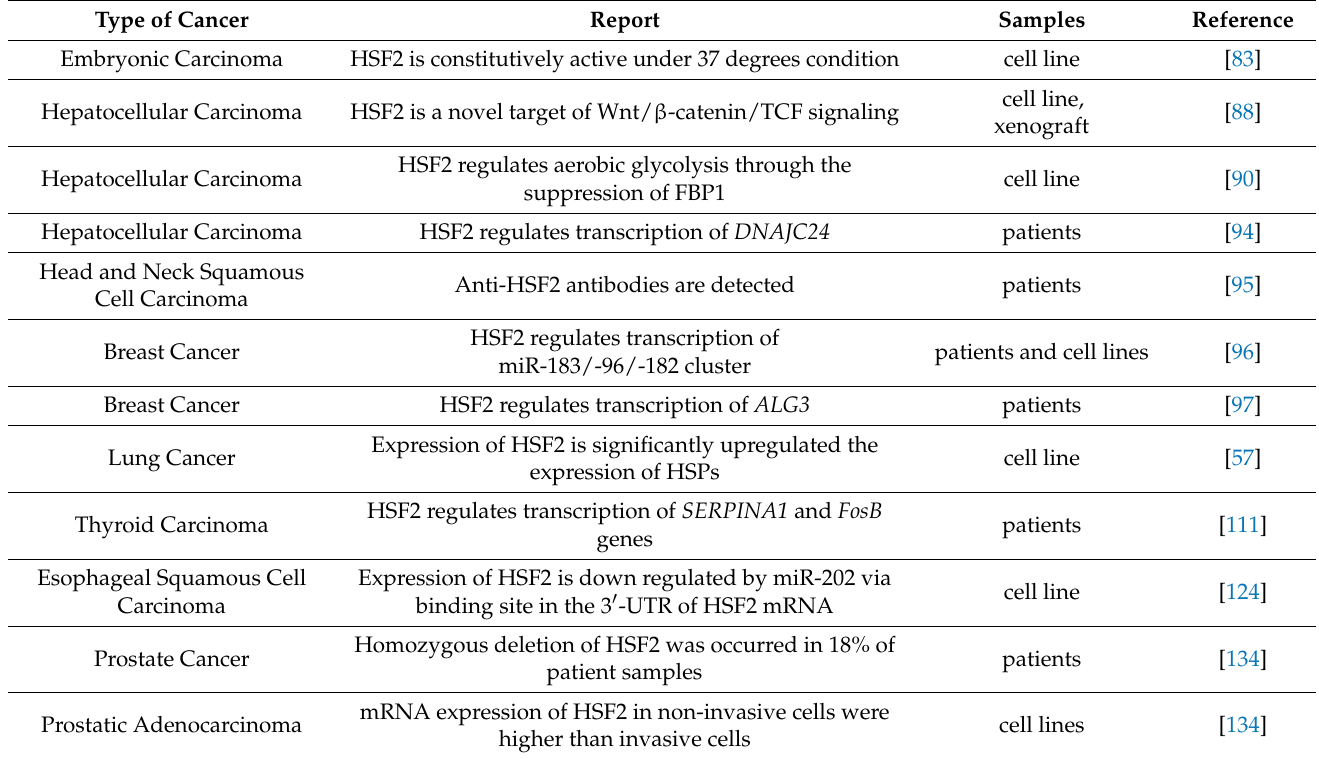
Table 1. List of studies on the relationship between HSF2 and